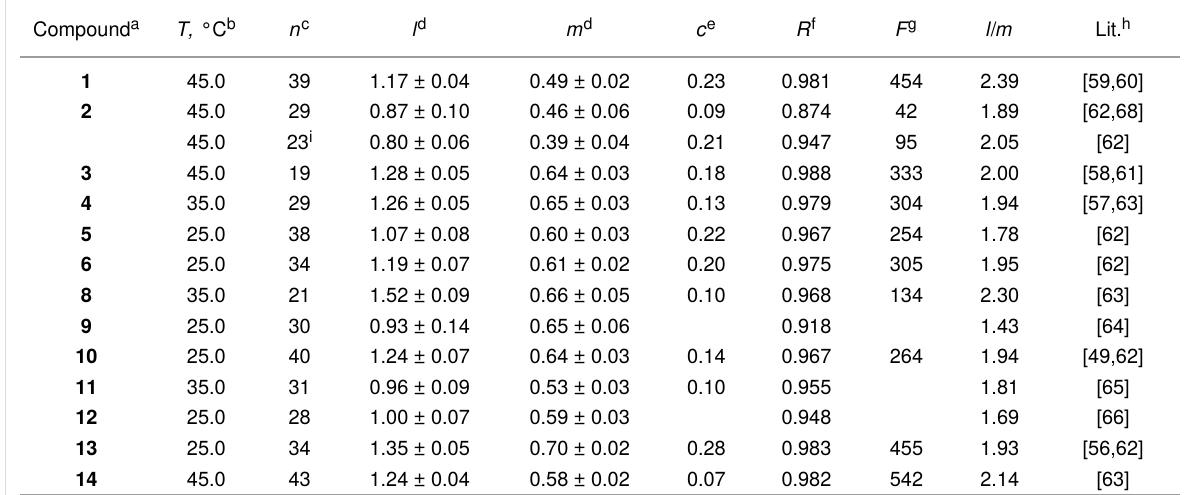
a See Table 1 for structures of substrates. b Temperature for the study. c Number of data points. d With associated standard error. e With associated standard error of 0.04 to 0.06, except 0.09 for 8 . f Correlation coefficient. g F -test value. h Publications from which the data points were assembled. i Values for 2,2,2-trifluoroethanol/ethanol mixtures omitted.